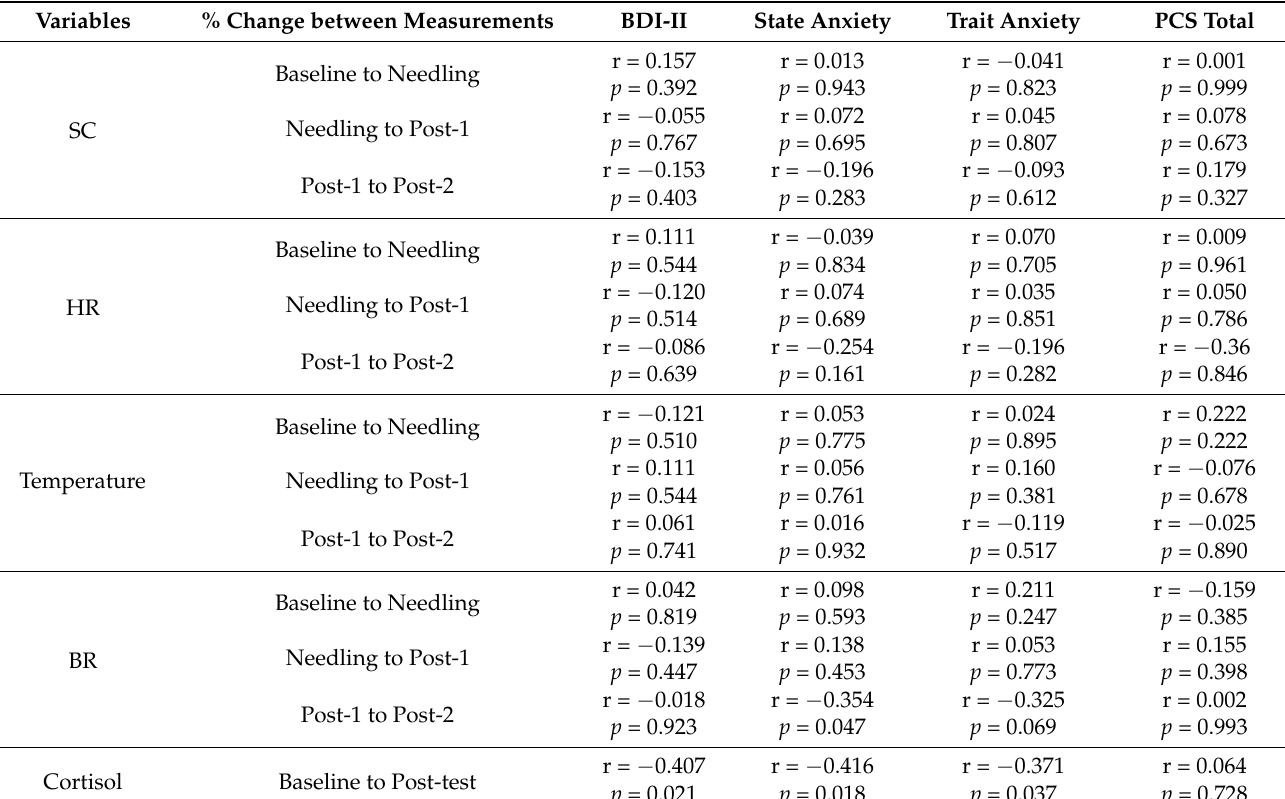
Table 6. Correlations between % Change of the Physiological Variables and Cortisol with Psychological Factors in the Placebo Group ( n =